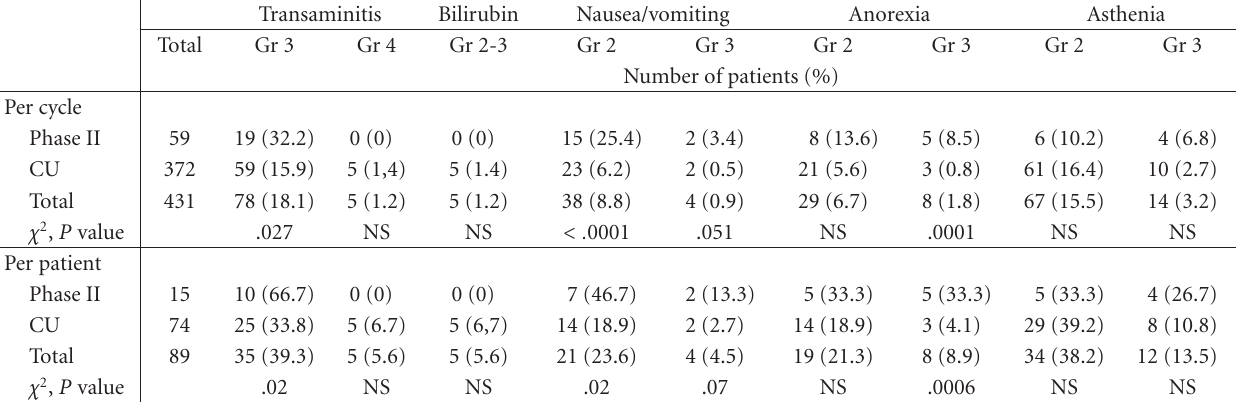
Table 6: Nonhematologic toxicities (NCI-CTC grade) per cycle and per patient. NCI-CTC, National Cancer Institute Common Toxicity Criteria; Gr, grade; NS, not